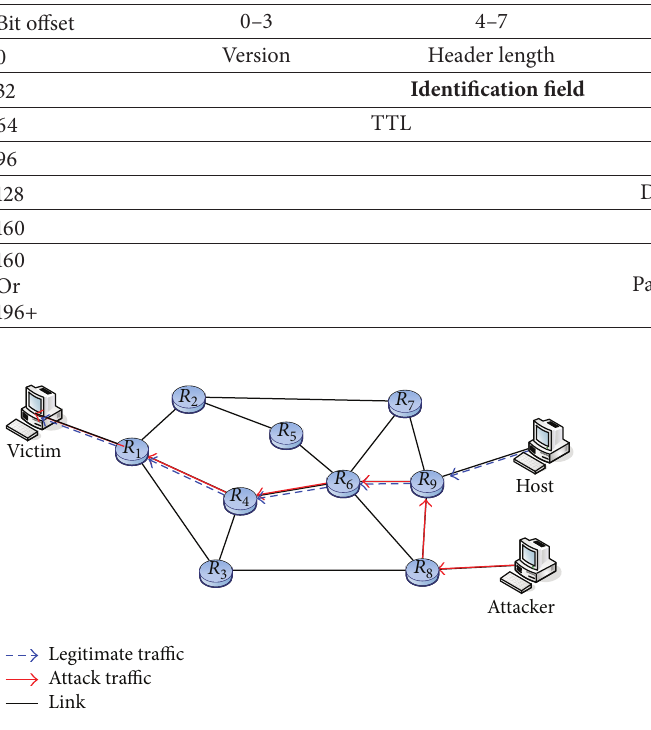
Table 1: Our marking field in an IP header (the bold text).